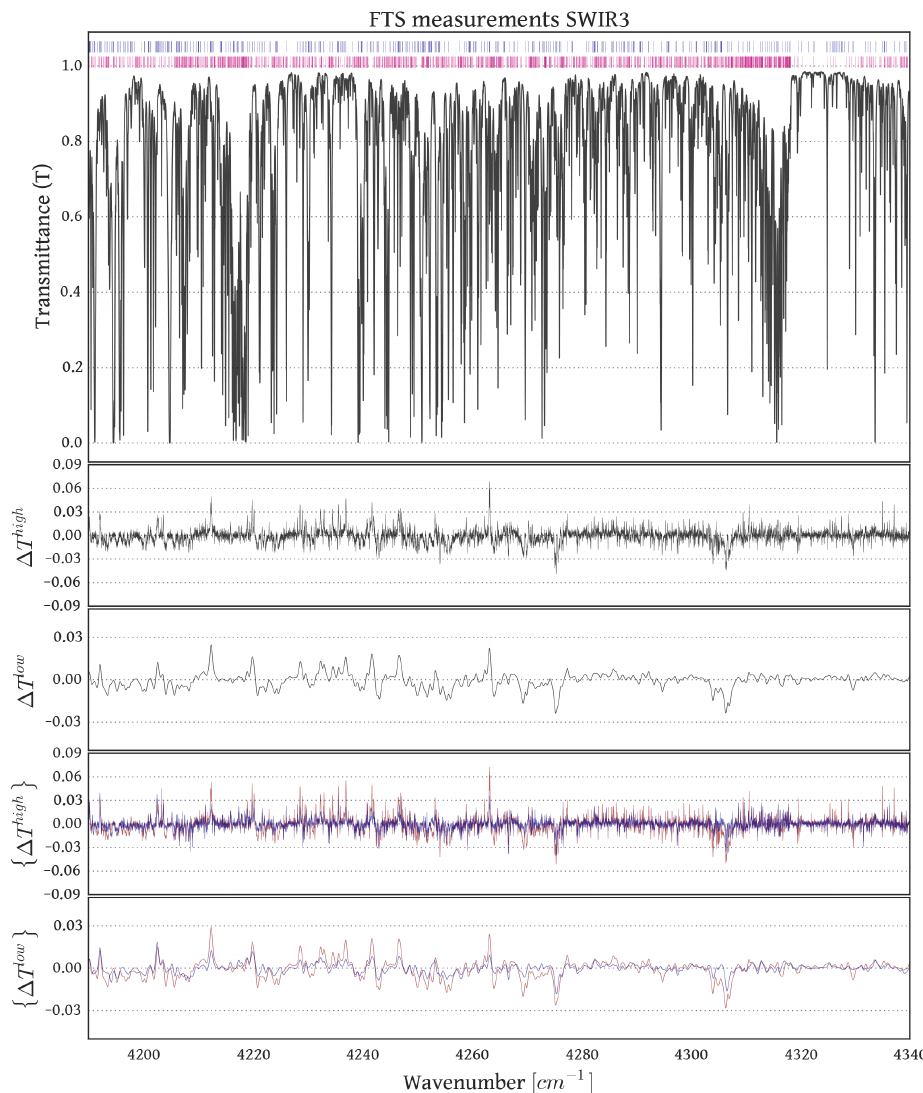
Figure 2. FTS transmittance spectrum in SWIR3 (upper panel), residual transmittance at FTS spectral resolution (first middle panel) and residual transmittance at S5/S5P spectral resolution (second lower panel). The last two panels show the average of four illustrative humid spectra (reddish lines) and four illustrative dry spectra (bluish lines) at FTS and S5/S5P spectral resolutions. The water vapor absorption lines (with line intensity ≥ 10 − 26 [moleccm − 2 ] ) are shown with blue vertical stacks. The methane absorption lines (with line intensity ≥ 10 − 23 [moleccm − 2 ] ) are shown with magenta vertical